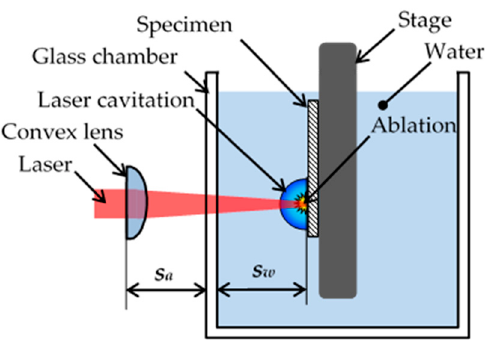
Figure 3. Schematic diagram of cavitation peening using a pulse laser, i.e., laser cavitation peening (LCP).